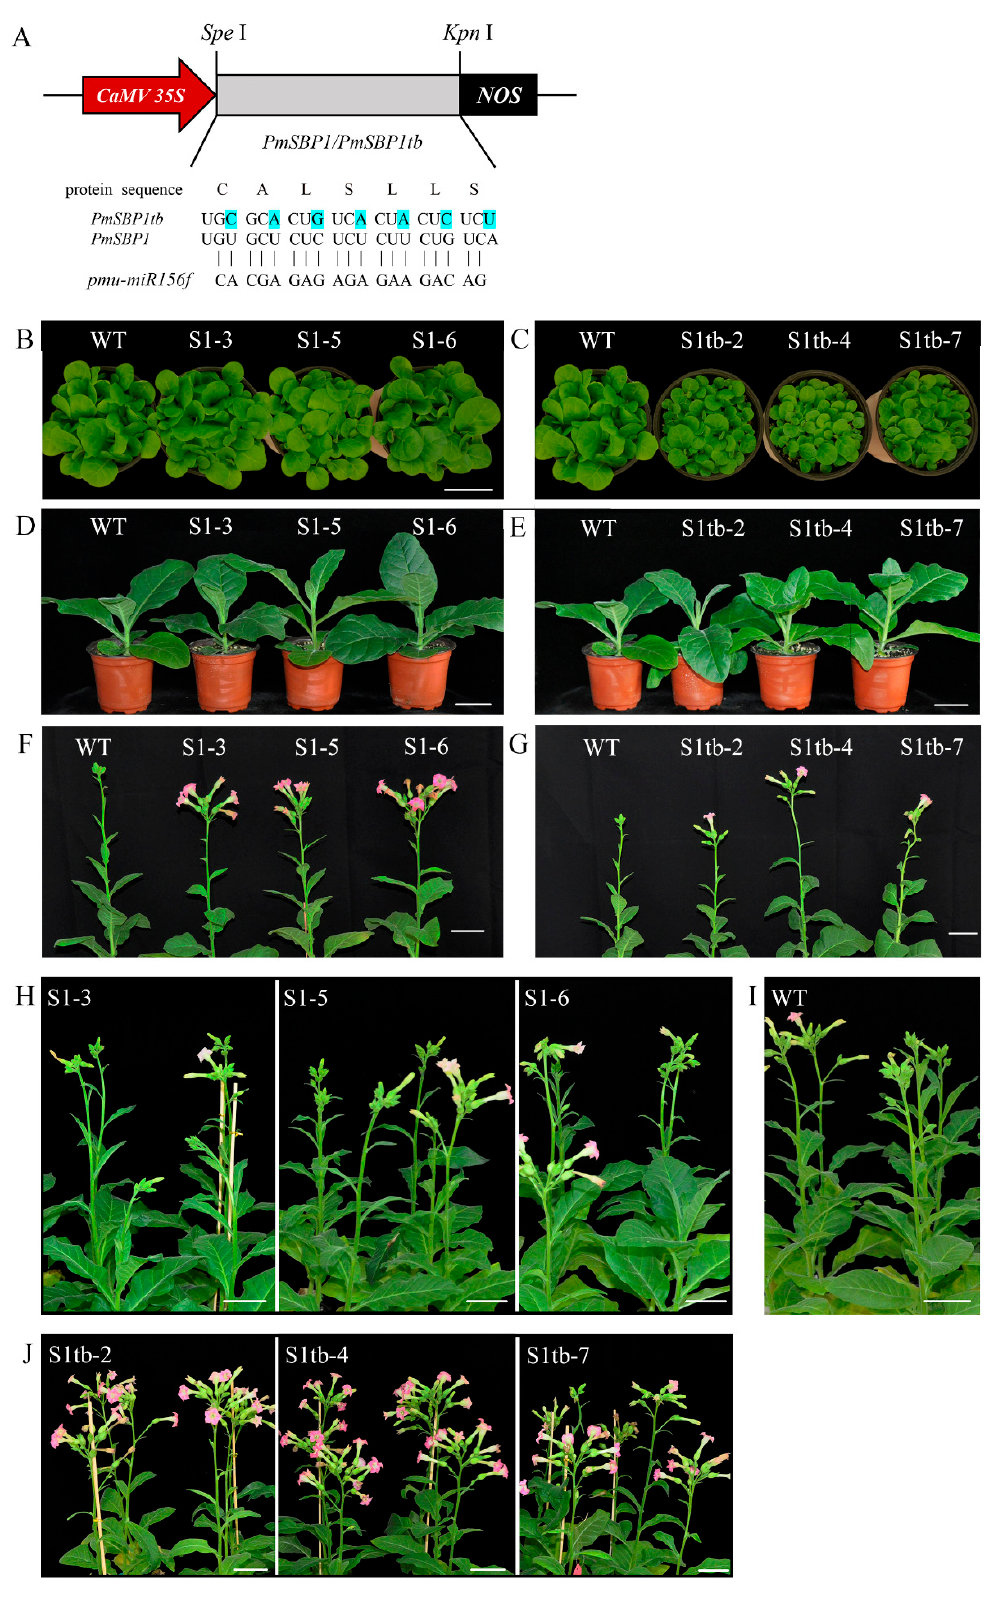
Figure 4. Overexpression of PmSBP1/1tb in tobacco. ( A ) The structure of PmSBP1/1tb recombinant vectors. ( B – E ) The phenotype of PmSBP1 and PmSBP1tb transgenic plants in the vegetative growth period (50 d and 80 d). ( F , G ) The flowering time of PmSBP1 and PmSBP1tb transgenic plants under short-day conditions (100 d). ( H – J ) The flowering time of PmSBP1, PmSBP1tb transgenic plants and WT under long-day conditions (110 d). The scale bar = 5 cm.